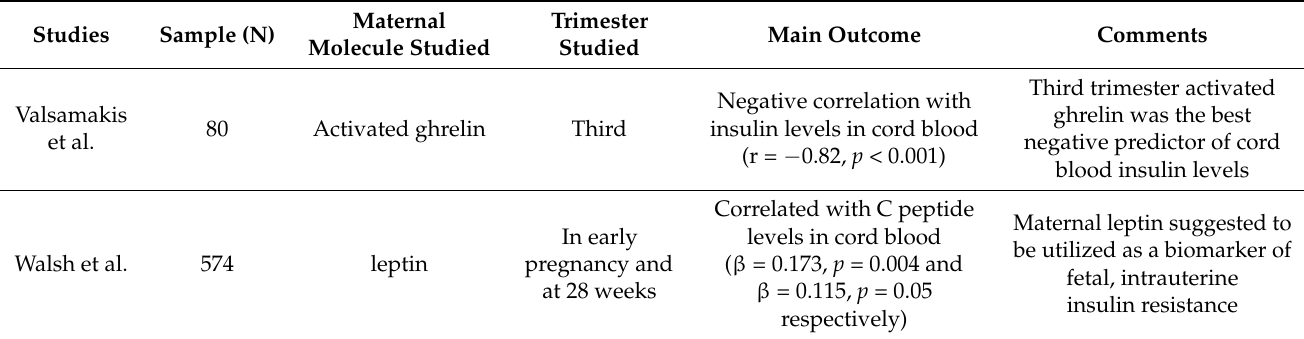
Table 4. Studies of maternal appetite molecule levels in relation to fetal metabolic indices in cord blood at